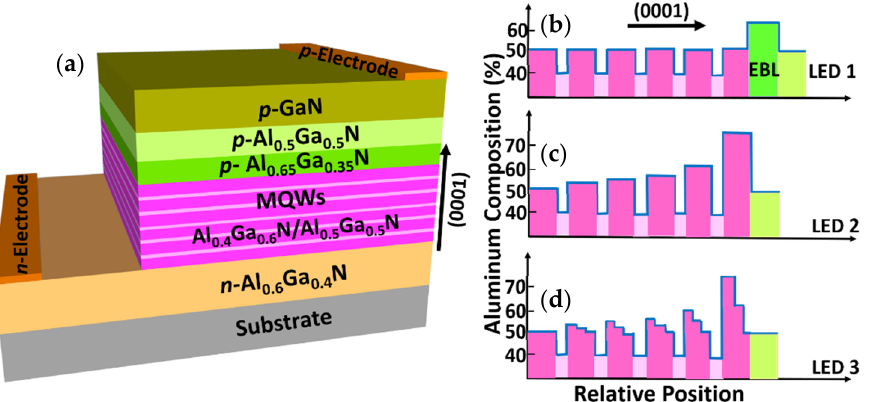
Figure 1. ( a ) Schematic diagram of light-emitting diode (LED) 1, Al composition (%) profile related to the conduction band of ( b ) LED 1 with conventional quantum barriers (QBs), ( c ) LED 2 with uniformly increasing Al composition in QBs, and ( d ) LED 3 with the proposed graded staircase quantum barrier (GSQB) structure.